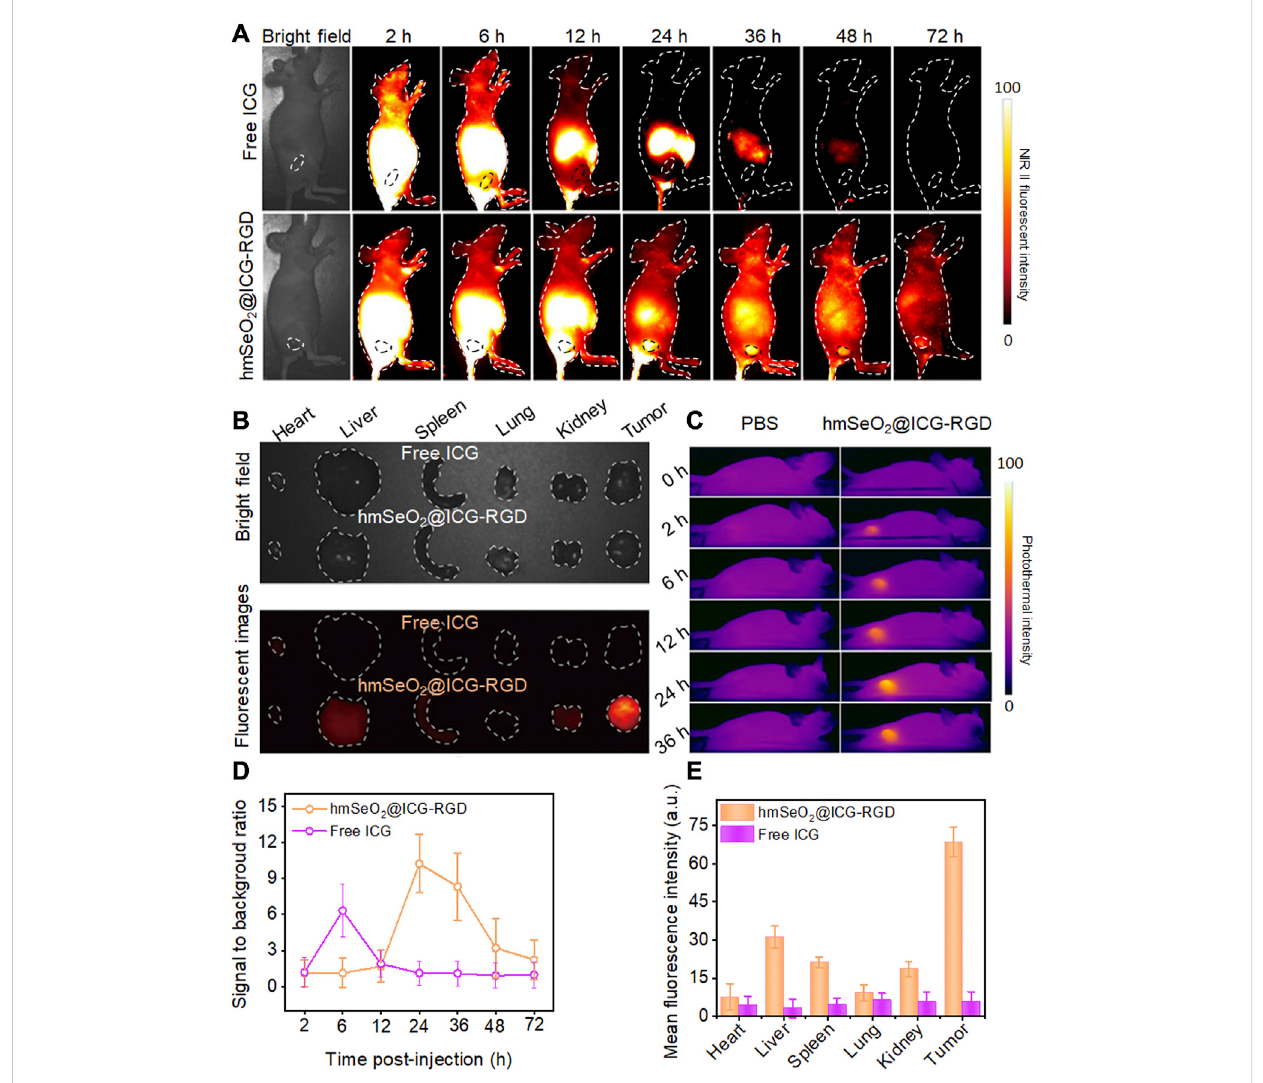
FIGURE 5 (A) NIRII fl uorescentimagesofbreastcarcinoma-bearingnudemiceafter tailveininjectionofhmSeO 2 @ICG-RGDandICGatdifferenttime-points. (B) Ex vivo bright fi eld and fl uorescent imaging of major organs (heart, liver, spleen, lung, kidney) and tumors dissected from mice after intravenous injection with hmSeO 2 @ICG-RGD and ICG for 72 h, respectively. (C) In vivo photothermal images of 4T1 tumor-bearing mice after treatment with free ICG and hmSeO 2 @ICG-RGD for various periods of time. (D) Signal to background ratios in 4T1 tumor-bearing mice after treatmentwith free ICG or